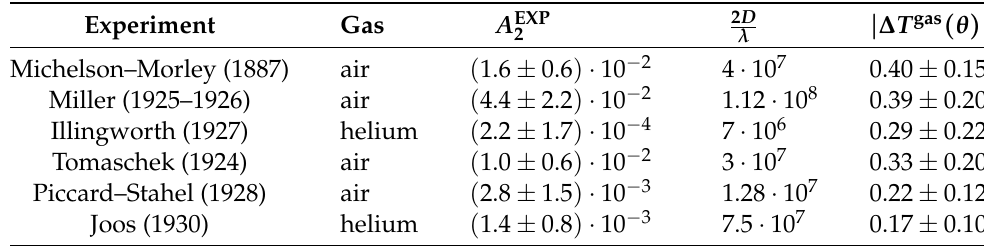
Table 3. The average second-harmonic amplitude observed in various classical ether-drift experi- ments and the resulting temperature differences (in mK) from Equation